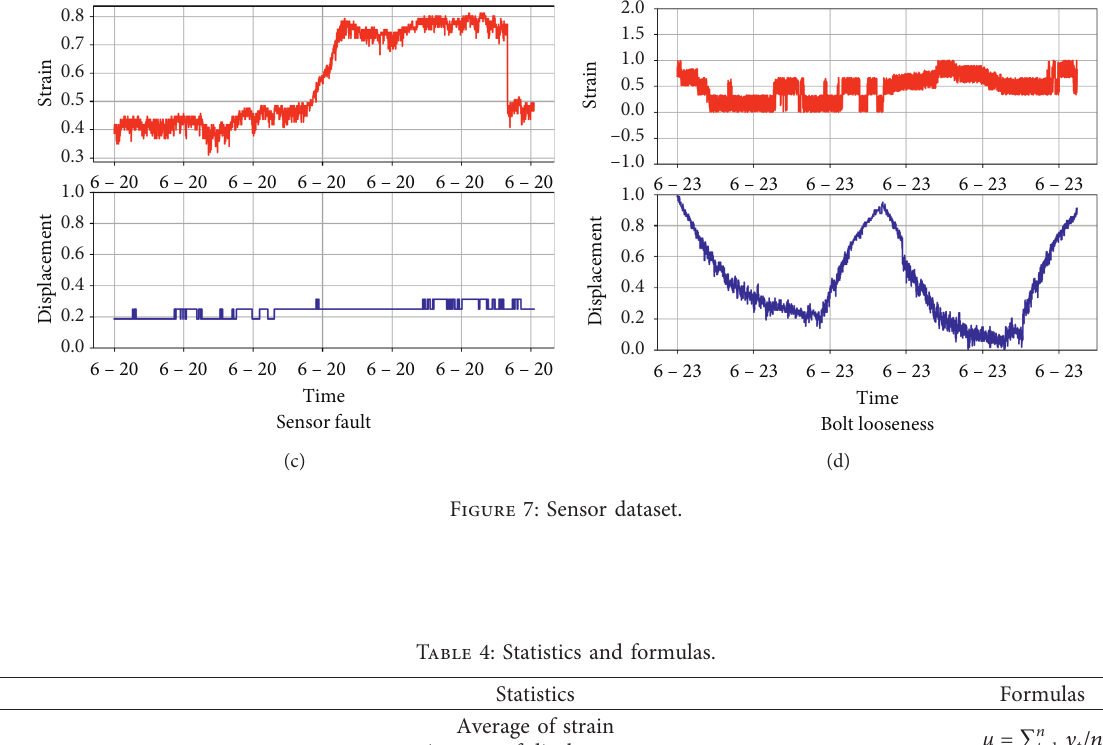
Figure 7: Sensor